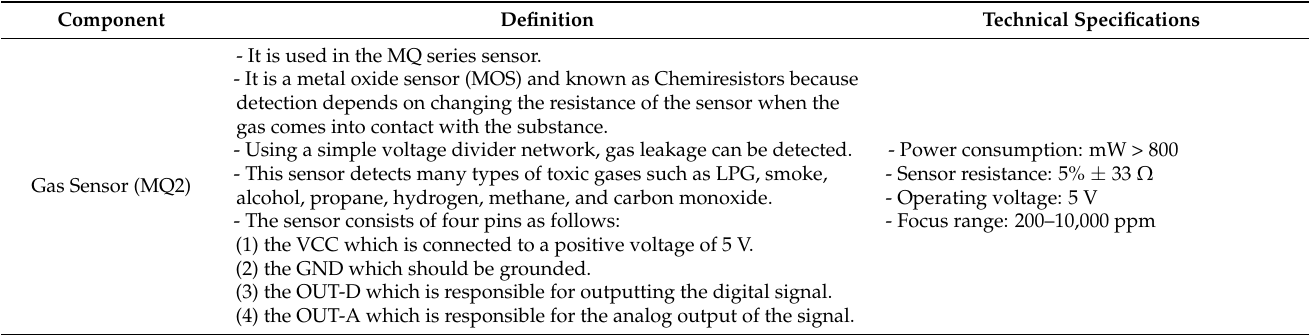
Table 6. The main components for the toxic gas warning system in the smart home.